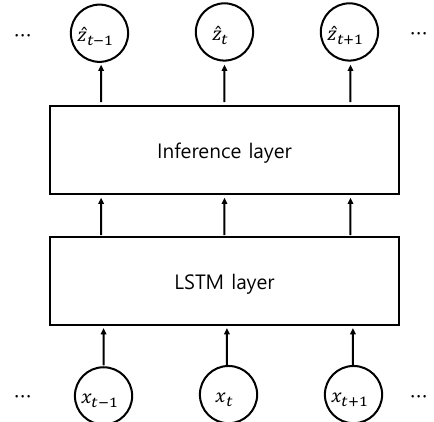
Figure 8. Schematic diagram for the inference